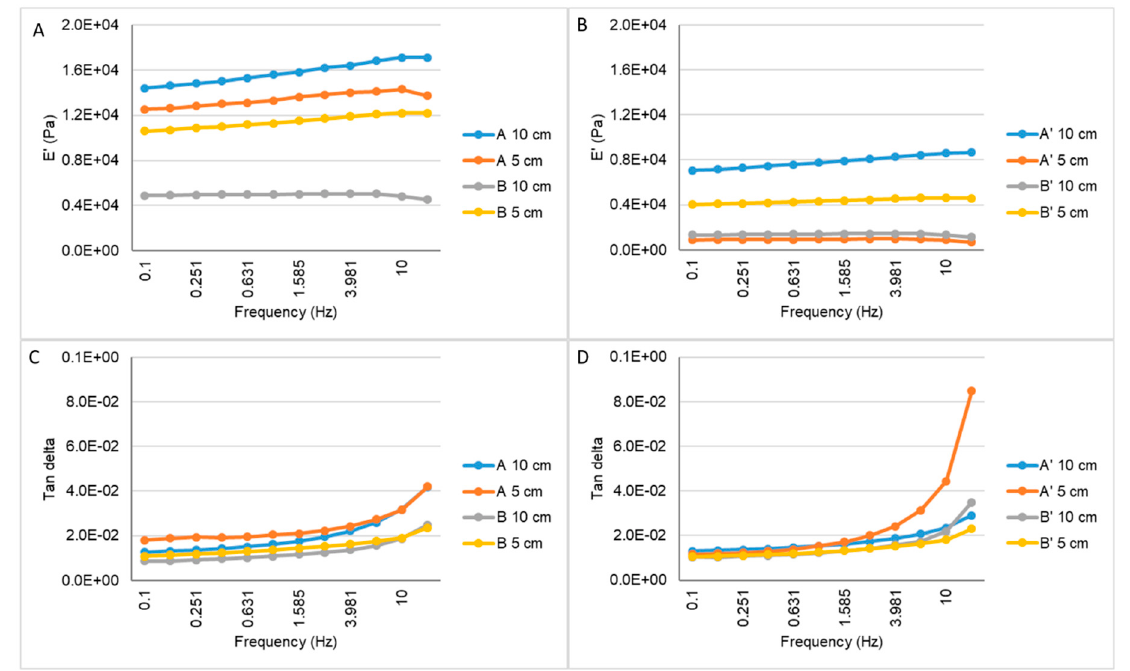
Figure 2. Storage modulus ( A and B ) and tan delta ( C and D ) under dynamic compression solicitation versus the increasing frequency, ranging from 0.1 to 10 Hz for Coll/nanoHA scaffolds produced with different collagens before (A and B) and after sterilization (A’ and B’).